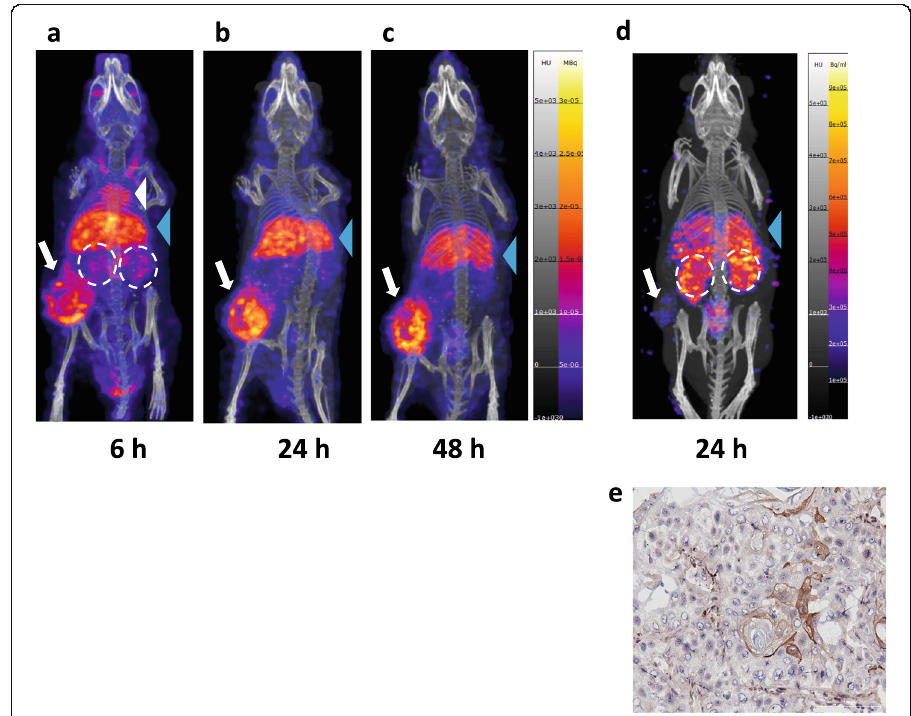
Fig. 4 Posterior whole-body coronal microSPECT/CT images of a NRG mouse bearing s.c. implanted HNSCC PDX at a. 6 h, b. 24 h or c. 48 h p.i. of [ 177 Lu]Lu-DOTA-panitumumab F(ab´) 2 or d. 24 h p.i. of irrelevant [ 177 Lu]Lu-DOTA-trastuzumab F(ab´) 2 . The tumour is shown by the white arrow. At 6 h p.i., the mediastinum (blood pool; white arrowhead), liver (blue arrowhead) and kidneys (broken white circles) were visualized, while at 24 and 48 h p.i., the liver and kidneys were the main normal organs visualized. e. Immunohistochemical staining of the excised tumour demonstrated very low HER2